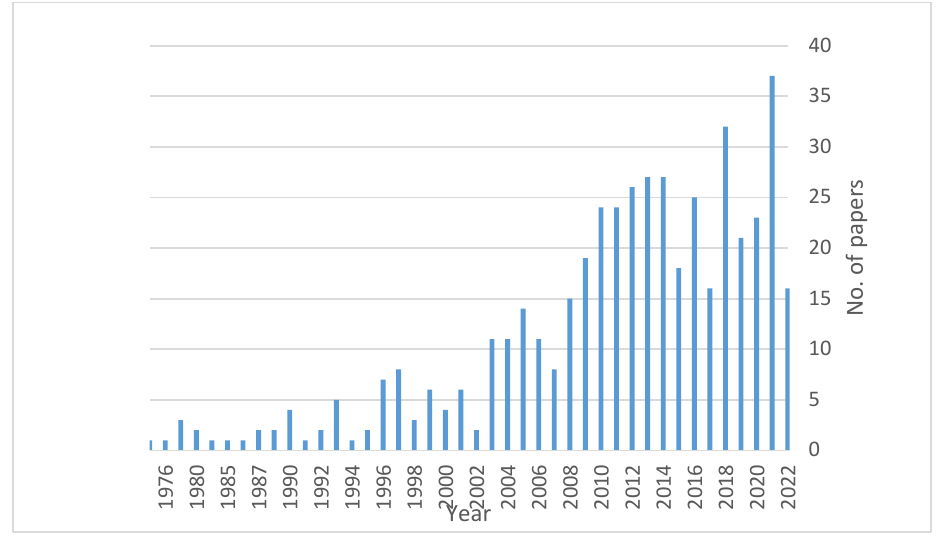
Figure 1. Annual distribution of the paper published on weeds–mycorrhiza interaction from 1975 to September 2022.